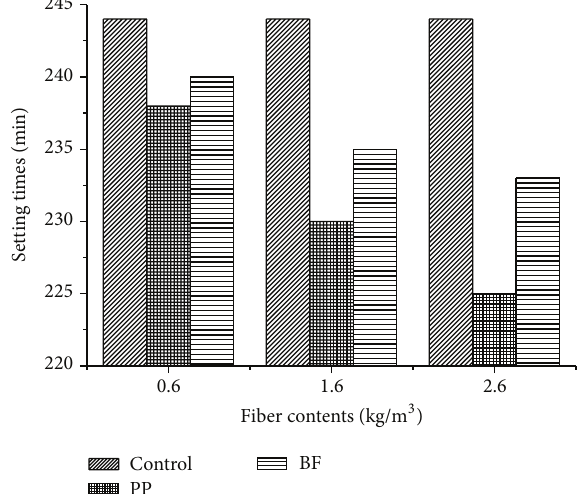
Figure 4: The effect of the replacement level of PP fiber and BF on the setting times of the